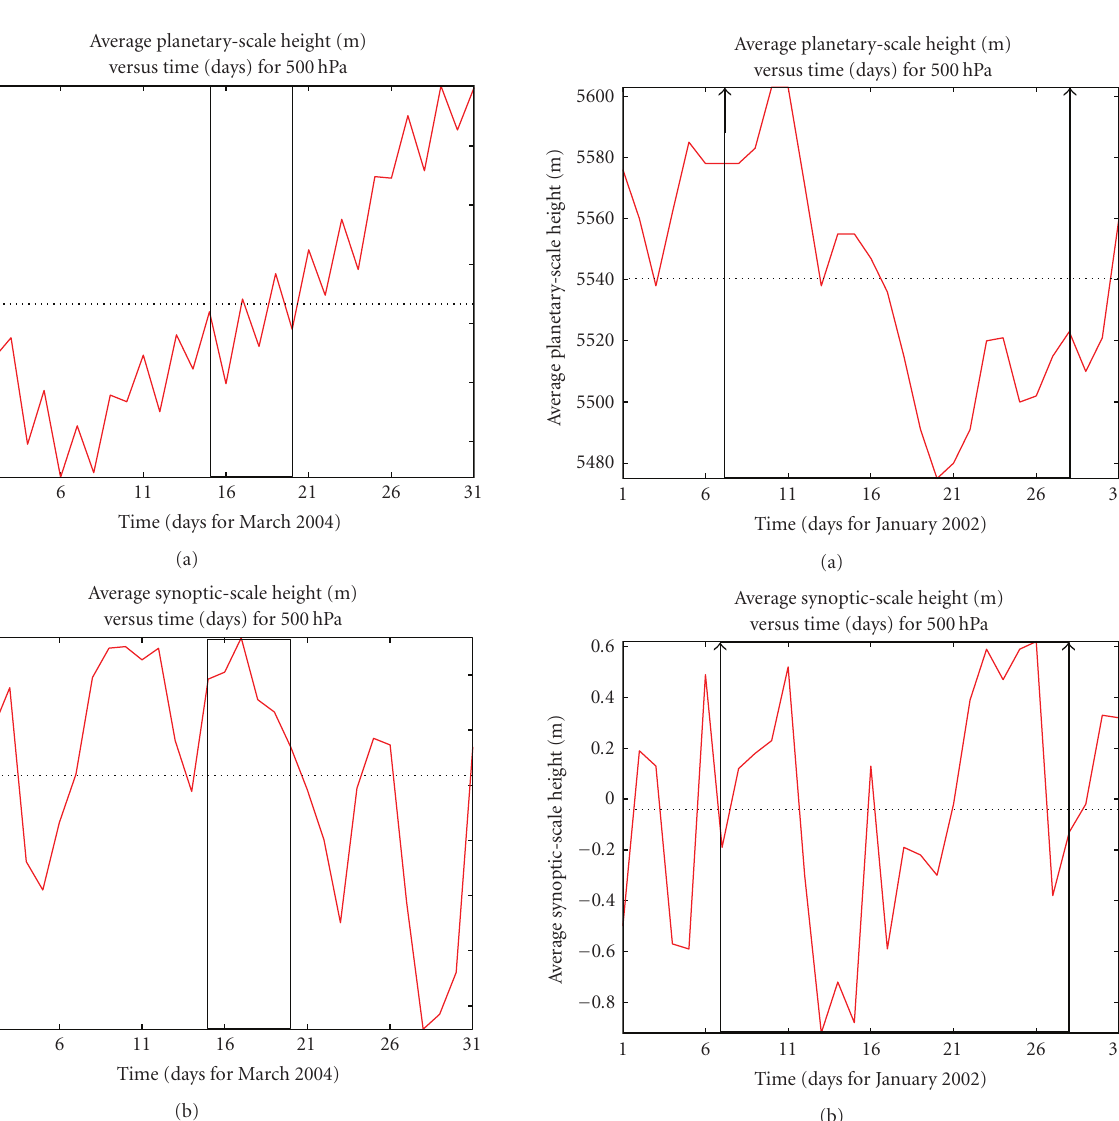
Figure 2: (a) The blocking area averaged planetary-scale 500hPa height (m) versus time (days), for a stationary box (20 ◦ N to 60 ◦ N and 290 ◦ E to 230 ◦ E), in the midlatitude northern hemispheric flow. The dashed dotted horizontal line defines the monthly mean value for the planetary-scale height. The left vertical upward arrow marks the beginning, whereas the right vertical upward arrow marks the end of the selected blocking event; (b) same as Figure 2(a) except for the synoptic-scale